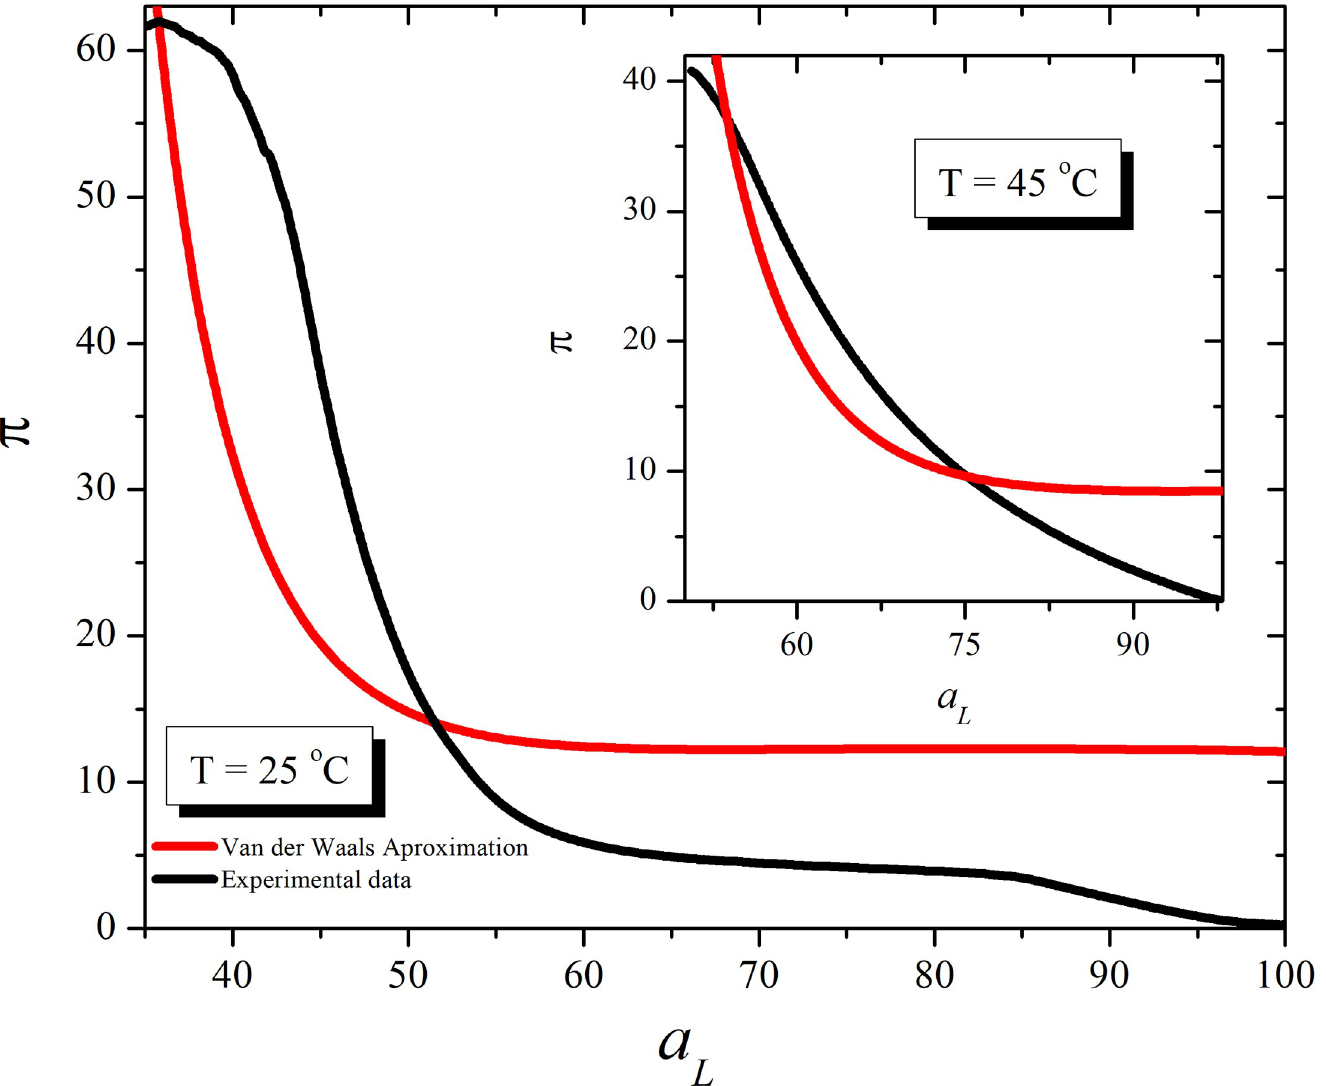
Fig 2. Surface pressure versus area per molecule for monolayer considered as van der Waals bidimensional gas. Same data of experimental curves as in Fig 1 (black line) are compared with a calculated π /A per lipid curves for DPPC considering the lipid monolayer as a van der Waals gas dispersed on an (inert) water surface at 25˚C(a) and 45˚C(b). The procedure was similar to that described in Fig